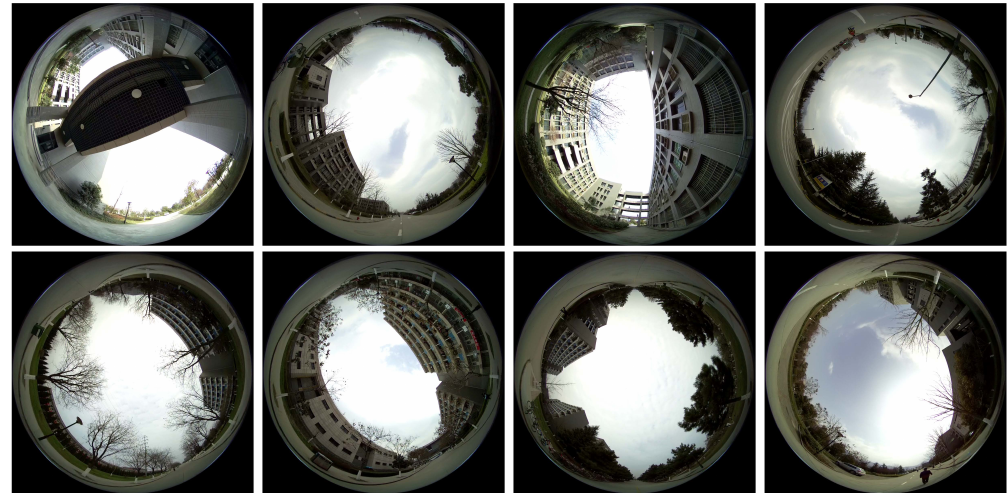
Figure 4. Sample images from the proposed Spherical-Navi dataset. Data collection is carried